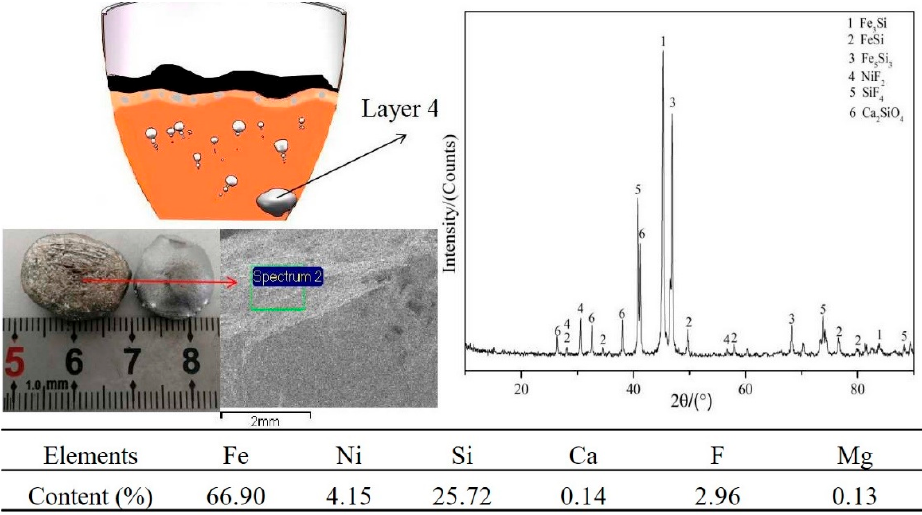
Figure 9. XRD pattern and EDS analysis of Layer 4.